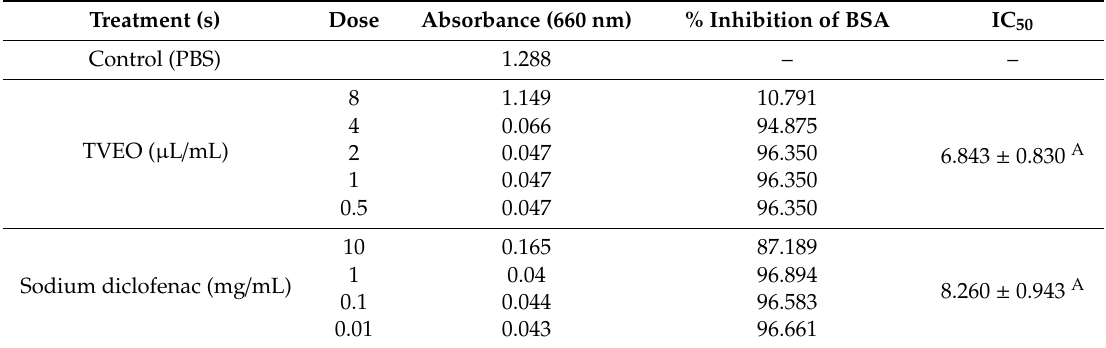
Table 5. E ff ect of Thyme essential oil on heat induced protein denaturation.